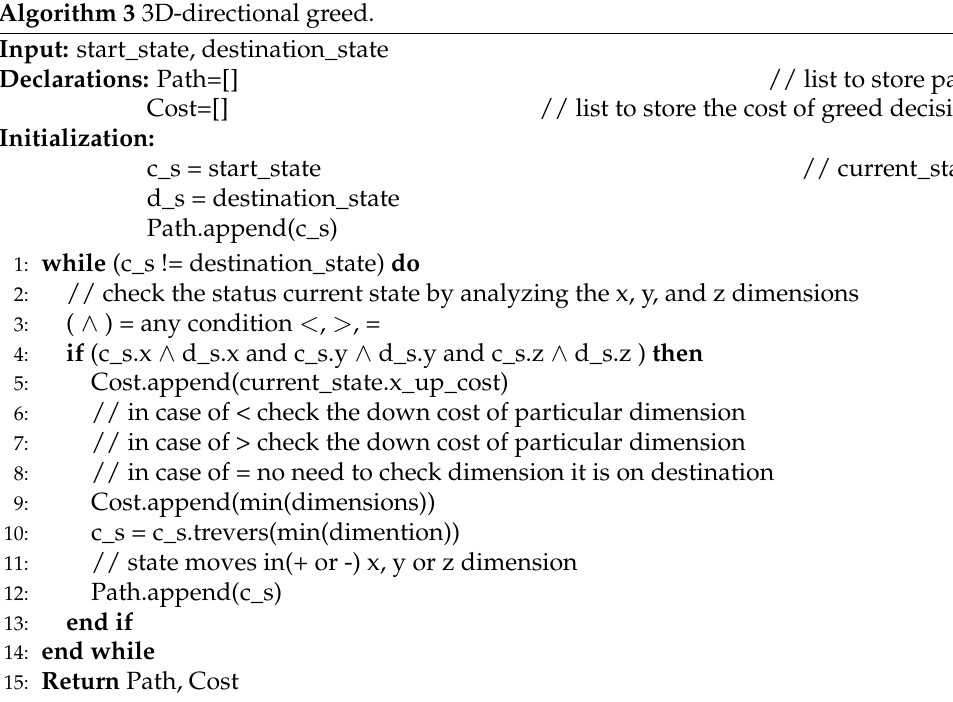
Algorithm 3 3D-directional greed.